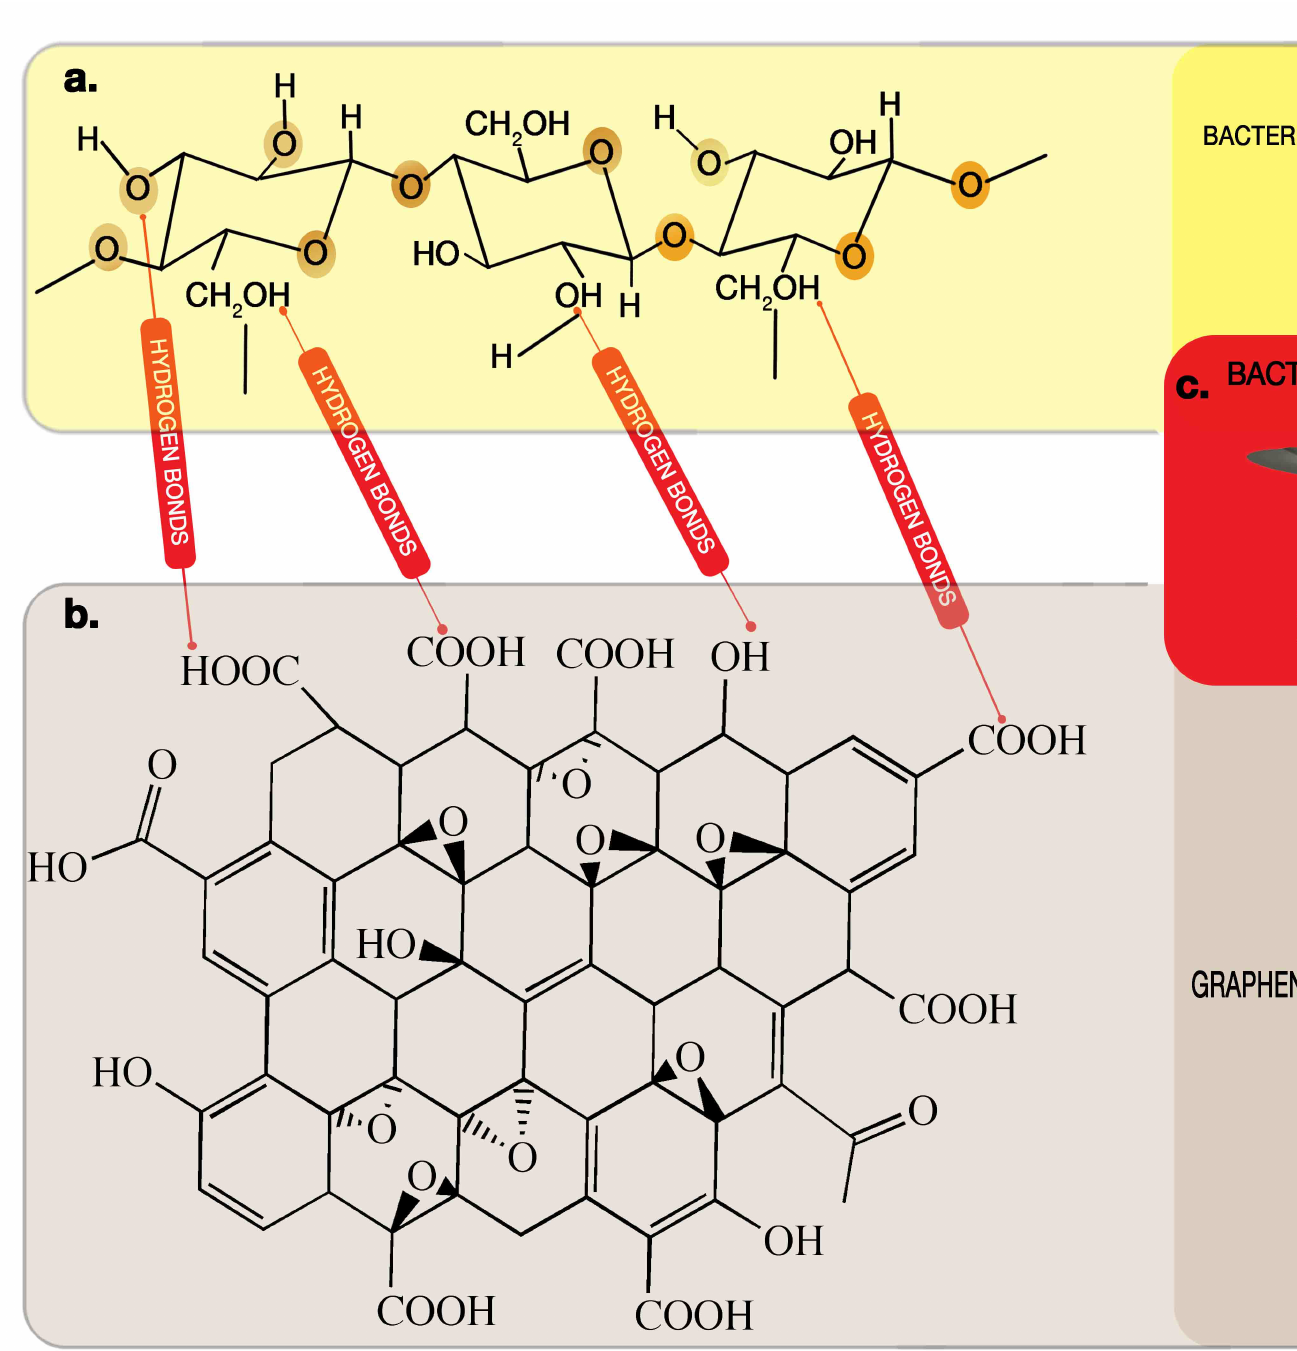
Figure 1. Synthesis of BC/GO membranes and their chemical structures. ( a ) Bacterial Cellulose (BC), ( b ) structure of Graphene oxide (GO) and ( c ) BC/GO (composites 1 and 2), obtained after hydrogen bonding and